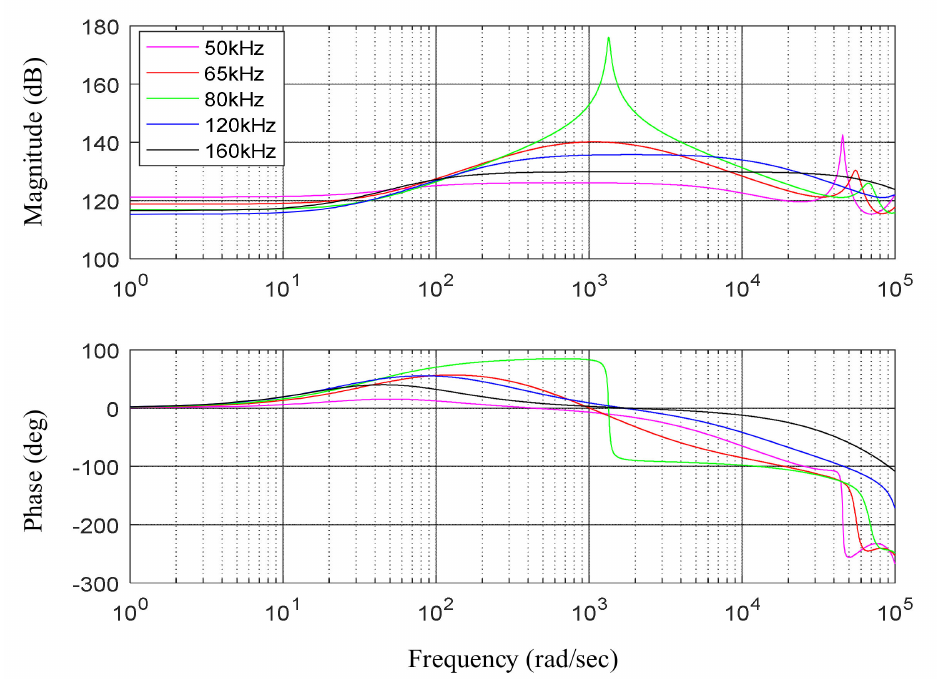
Figure 9. Bode diagram of system transfer function Git